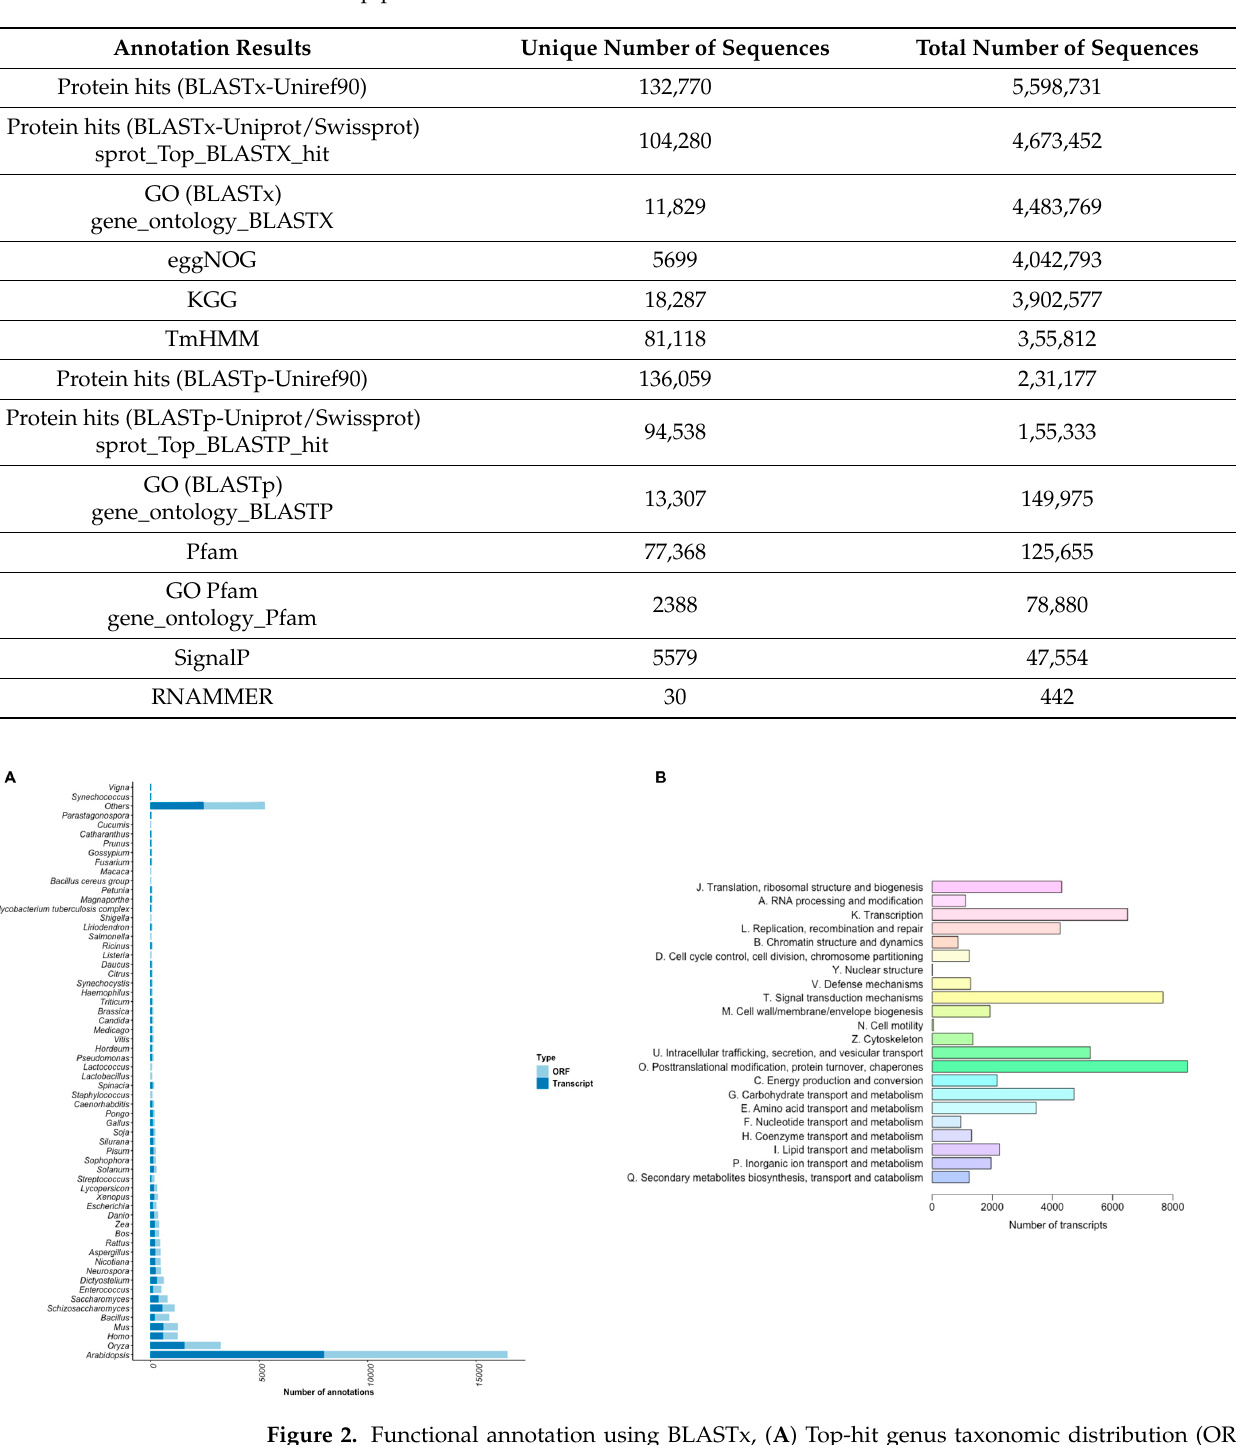
Table 1. Number of unique and total functional annotation of the soursop fruit transcriptome using Trinotate pipeline.